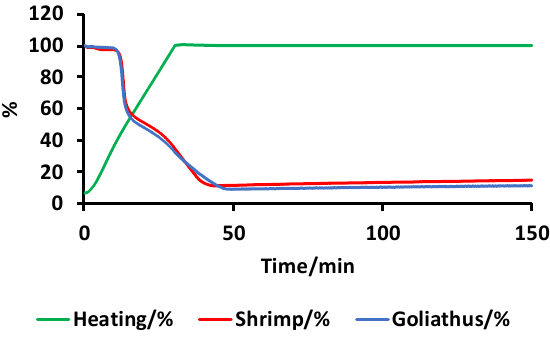
Figure 11. Thermogravimetric measurements for chitosan from G. orientalis (blue) and shrimp (red).